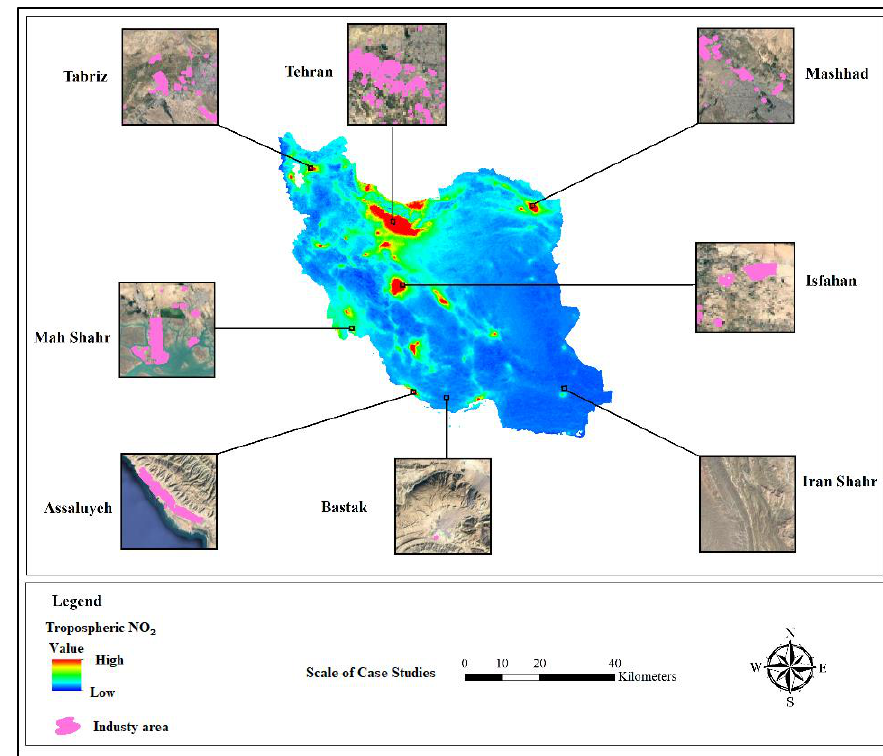
Figure 9. Spatial distribution of ground truth data points in the study area.